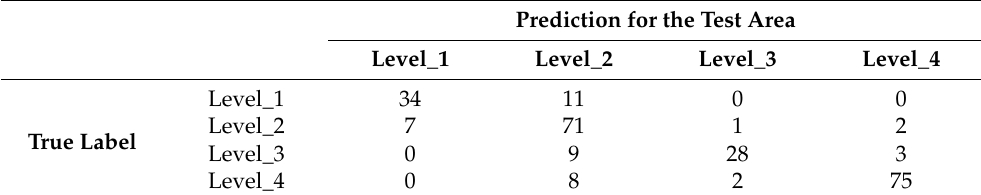
Table 6. Confusion matrix of the damage classification for the buildings in the test area.